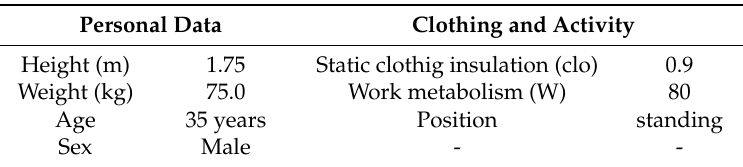
Table 2. Physiological